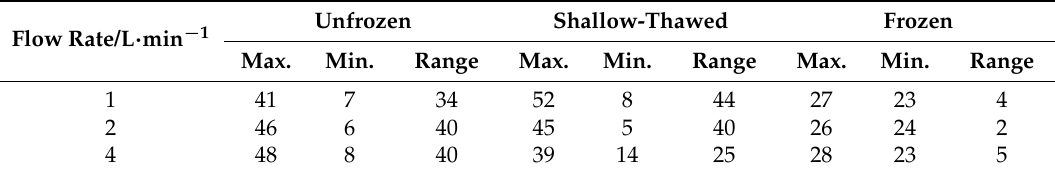
Figure 6. Spatial distribution of the runoff energy consumptions over the unfrozen (UF), shallow-thawed (ST), and frozen (F) slopes for different flow rates. Table 4. Descriptive statistical contributions of the runoff energy consumption for the four sections during each experiment (%).